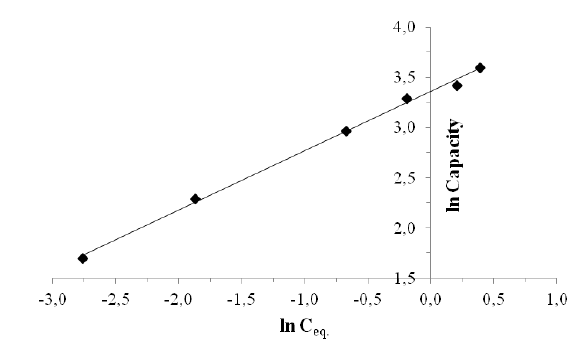
Figure 5: Isotherm of palladium sorption by a modified humic sor- bent in logarithmic coordinates.